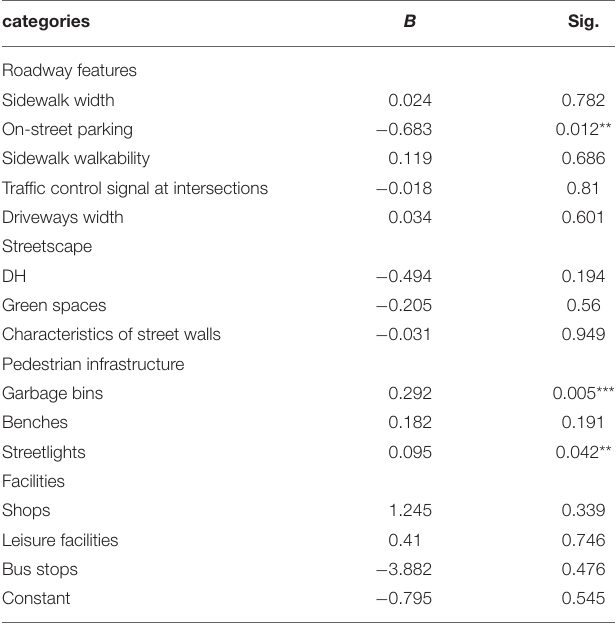
TABLE 6 | Street environmental factors affecting non-selected shortest routes.